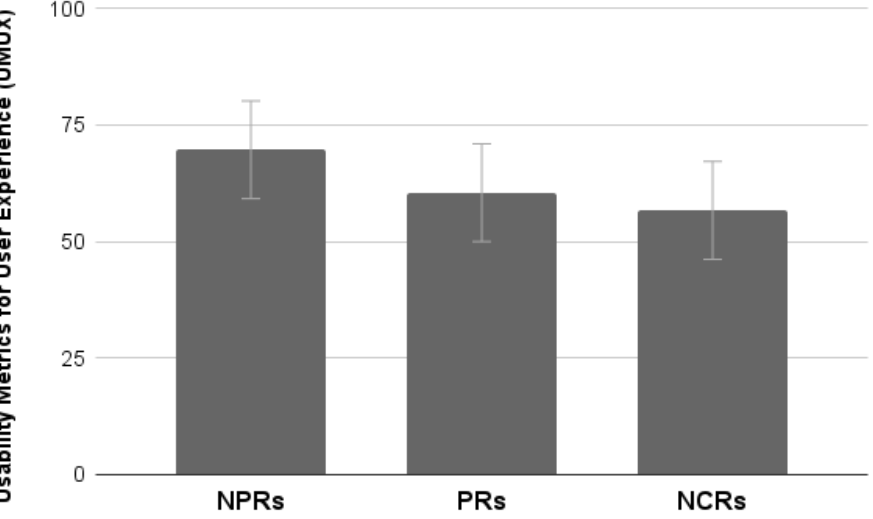
Figure 18. UMUX score by Group (NPRs vs. PRs vs. NCRs). Error bars denote 0.95 confidence in- tervals.